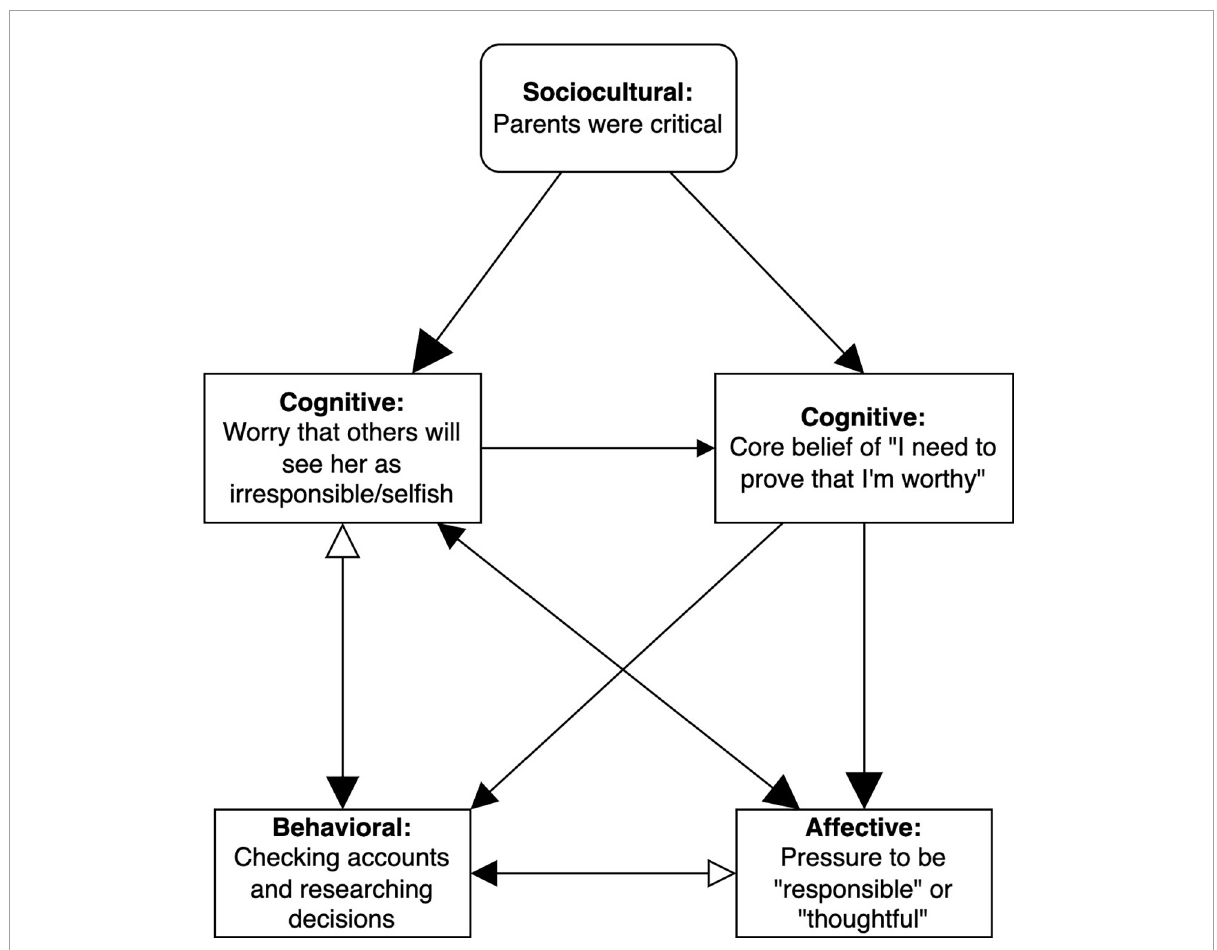
FIGURE4 Subnetwork with inhibitory effects. EEMM dimensions represented by each node are bolded. Size of the arrowheads indicates hypothesized strength of the relationship (bigger arrowheads = stronger correlation), and opacity reflects direction of the relationship (opaque = positive/excitatory, transparent = negative/inhibitory). Right-angled rectangles reflect manipulable variables and rounded rectangles indicate immutable moderators (e.g., historical